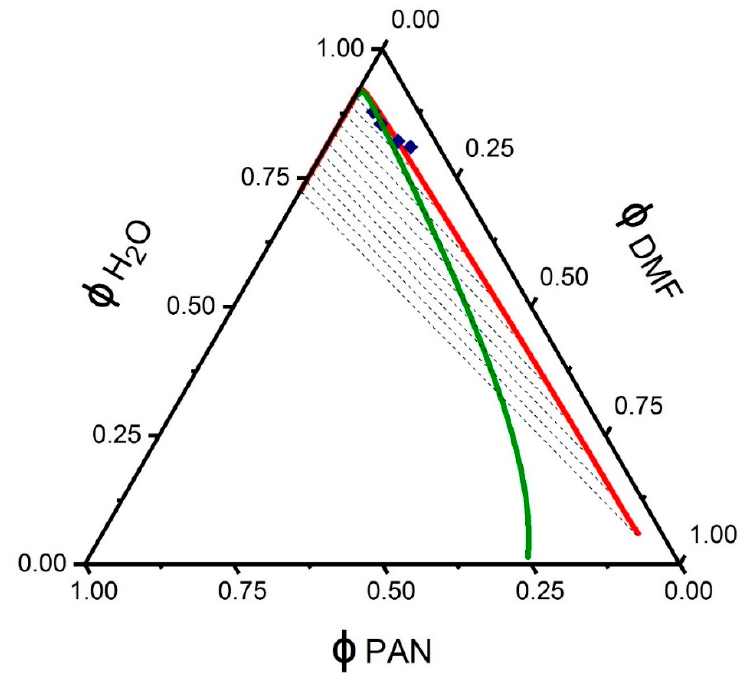
Figure 1. Obtained ternary phase diagram for PAN/H 2 O/DMF. The binodal curve has been fitted against experimentally determined cloud point compositions (blue squares). The spinodal curve and tie lines are indicated in green and gray, respectively.